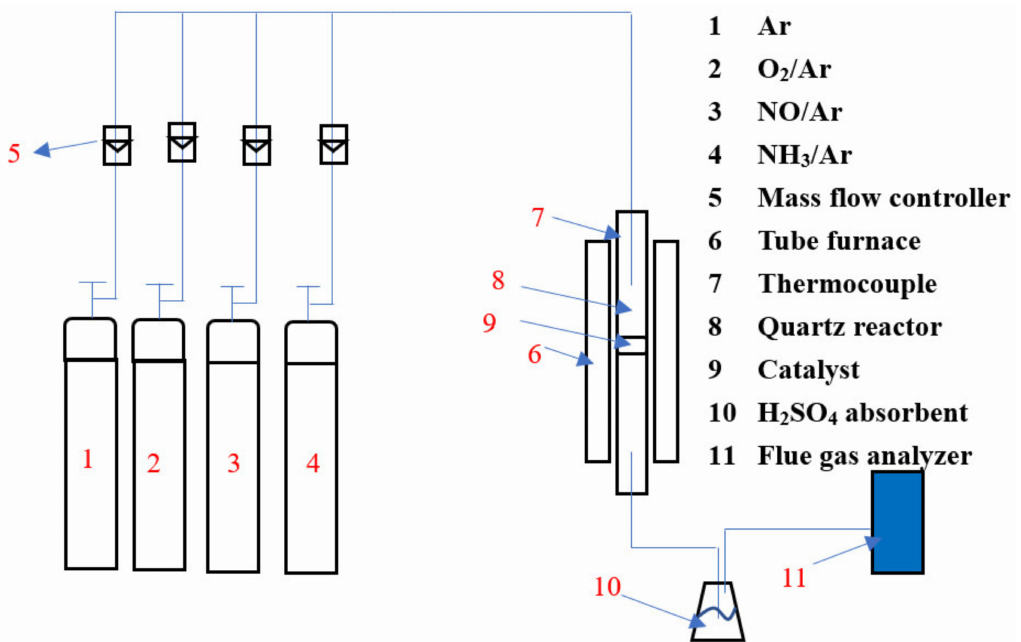
Figure 1. The experimental setup for selective catalytic reduction (SCR) evaluation.